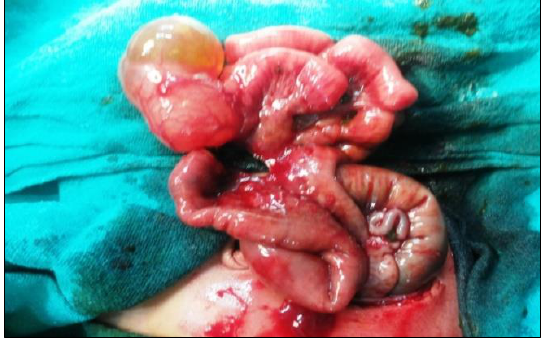
Figure 2: Peroperative photograph of ileal duplication cyst with atretic ileal segment.